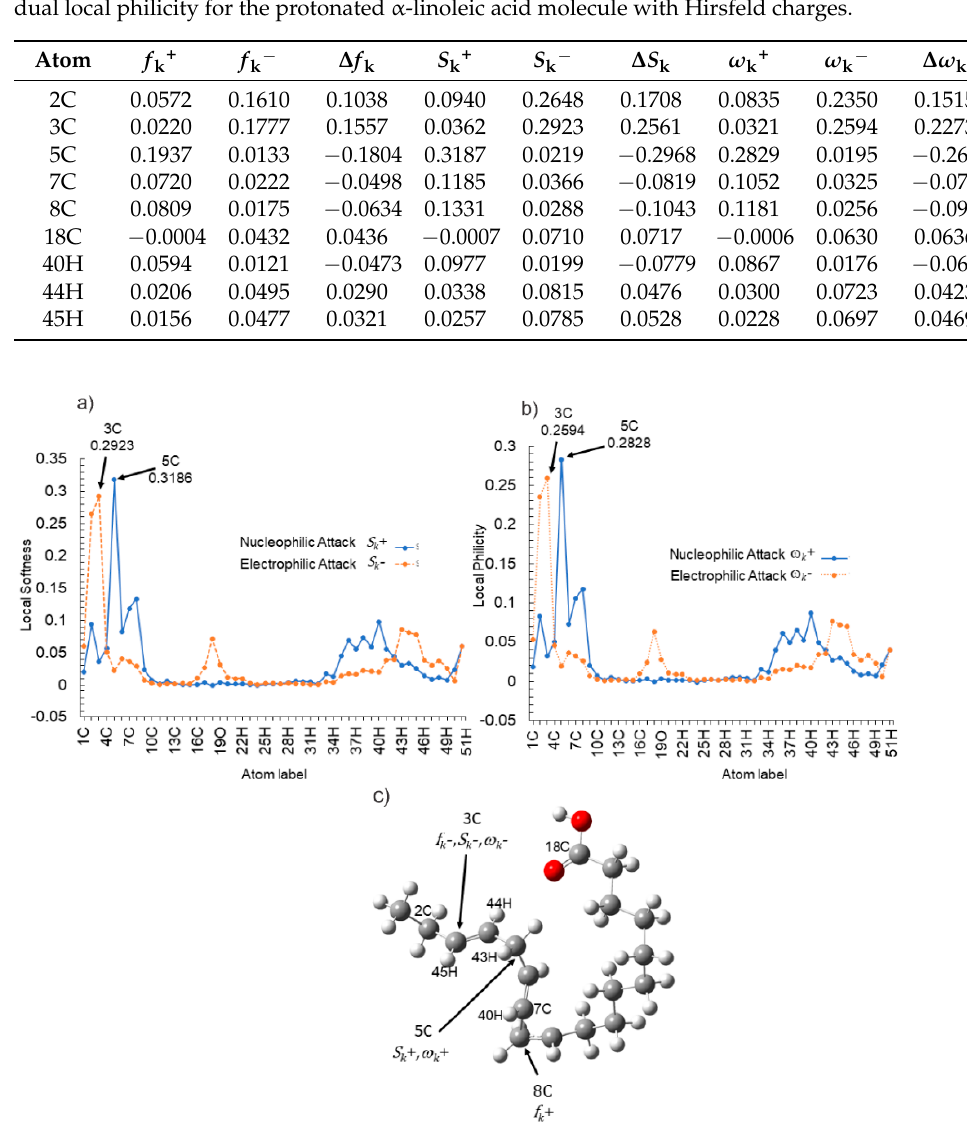
Figure 16. Graphical representation of the local dual descriptors nucleophilic attack and electrophilic attack ( a ) local softness S k + , S k − , ( b ) local philicity ω k + , ω k − and ( c ) nucleophilic and electrophilic attack on hetero-atoms for the protonated α -linolenic acid using the Fukui function, local softness and local